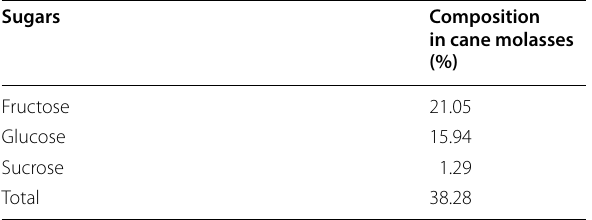
Table 1 Composition of sugars in cane molasses